Question: Looking at the figure, what chart type is it?
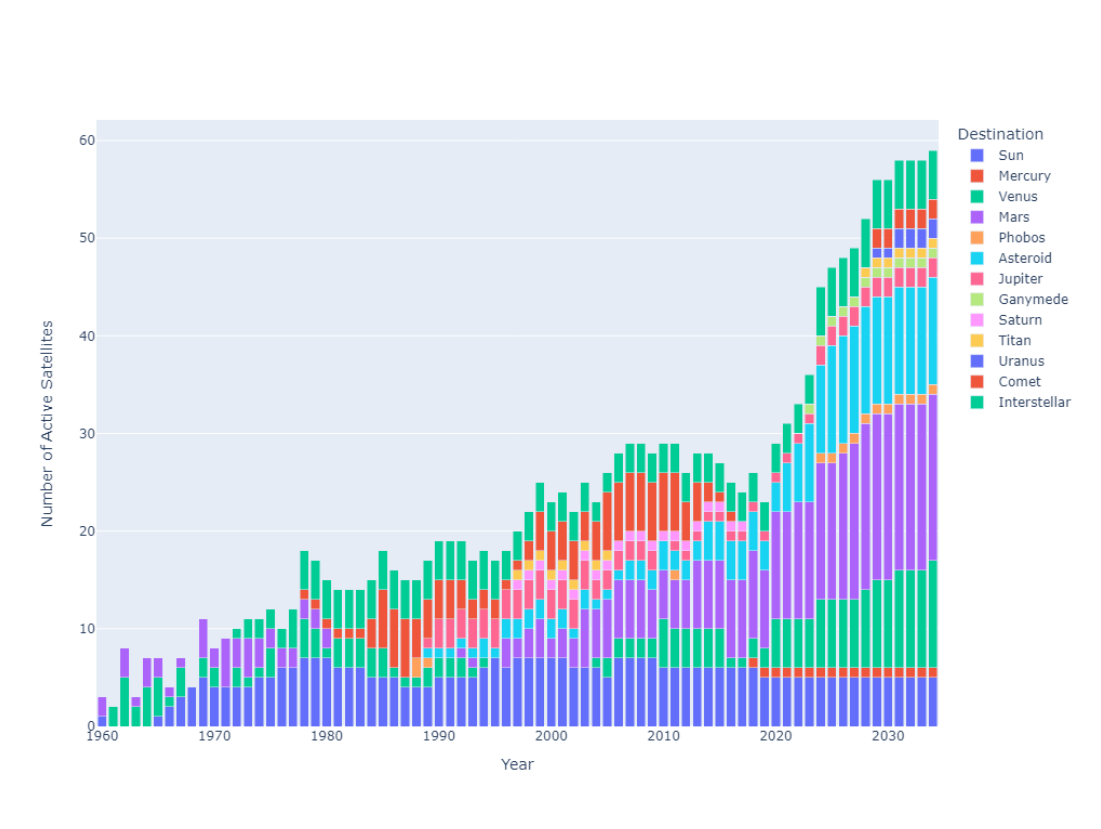
Answer: line